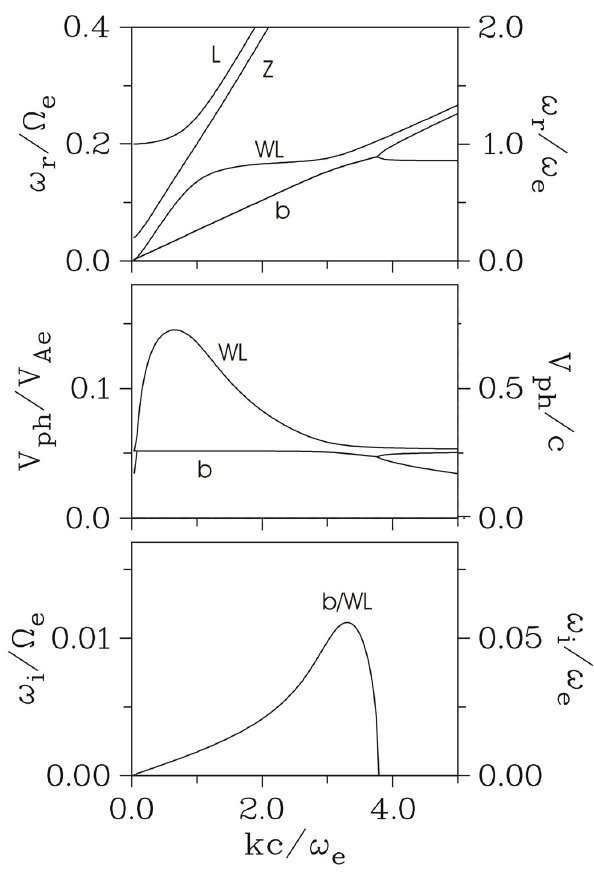
Fig. 7. Excitation of whistler-Langmuir waves by an electron beam and related dispersion of the three wave modes in the vicinity of the electron plasma frequency ω e for an (underdense) plasma with G = (cid:127) e / ω e = 5 at oblique propagation, θ = 30 ◦ , see also Fig. 2. The beam density is n b / n o = 0 . 001 and beam velocity V b /c = 0 . 3. The WL mode becomes unstable and has its maximum growth rate at kc/ω e ∼ 3 . 3, which follows from the resonance condition kV b ∼ ω e . The notation “b/WL” should indicate that the instability arises from the interaction of the beam (b) with the whistler-Langmuir (WL)